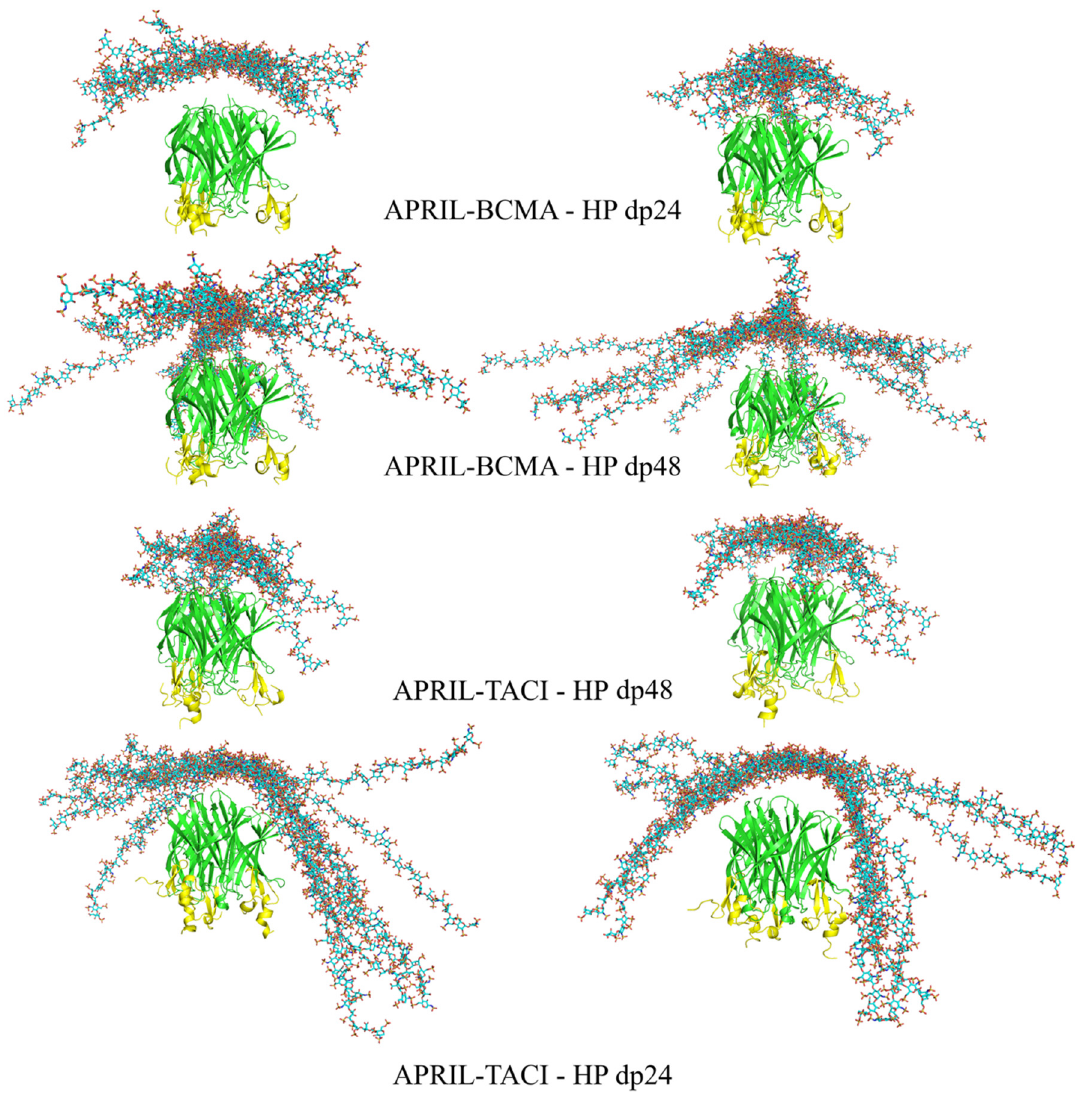
Figure 3. The most energetically favorable ( left ) and manually chosen ( right ) structures of the APRIL–BCMA and APRIL– TACI complexes with HP dp24 and HP dp48 after RS-REMD simulation (HP in licorice representation, cyan color; APRIL (green color) and BCMA/TACI (yellow color) in cartoon representation).